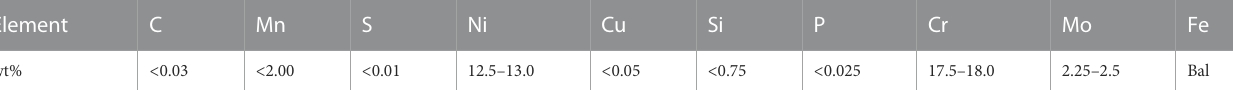
TABLE1 Chemical composition of 316 L powder. Element